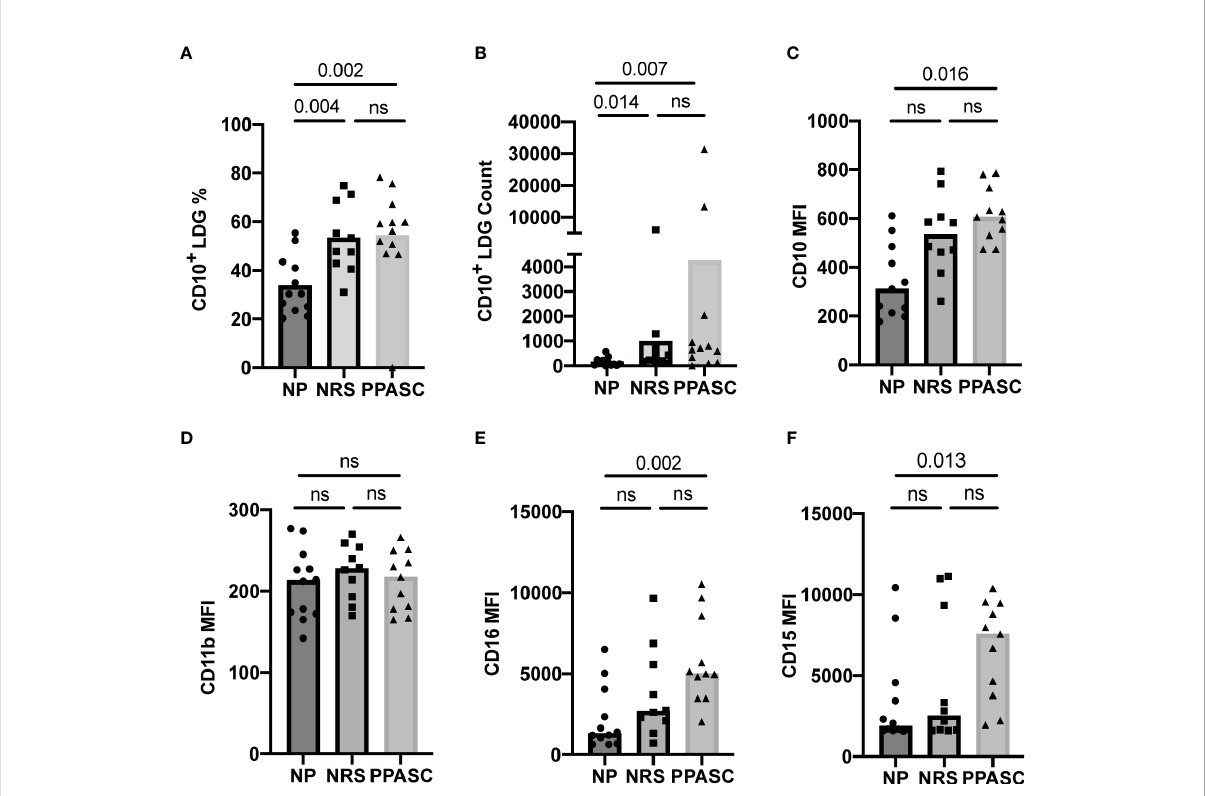
FIGURE 2 LDG display a mature phenotype in COVID-19 convalescents. Mature LDGs were identi fi ed by their CD10 expression. The percentage (A) and total number (B) of CD10 + cells in the LDG fraction were compared across three groups. Analysis of surface marker expression on circulating LDGs and median fl uorescence intensity (MFI) of CD10 (C) , CD11b (D) , CD16 (E) , and CD15 (F) on LDGs in NP, NRS, and PPASC groups. Graphs are shown as bar with scatter dot plots. Comparisons between groups were performed using Mann-Whitney U test. ns, non-signi fi cant, p >